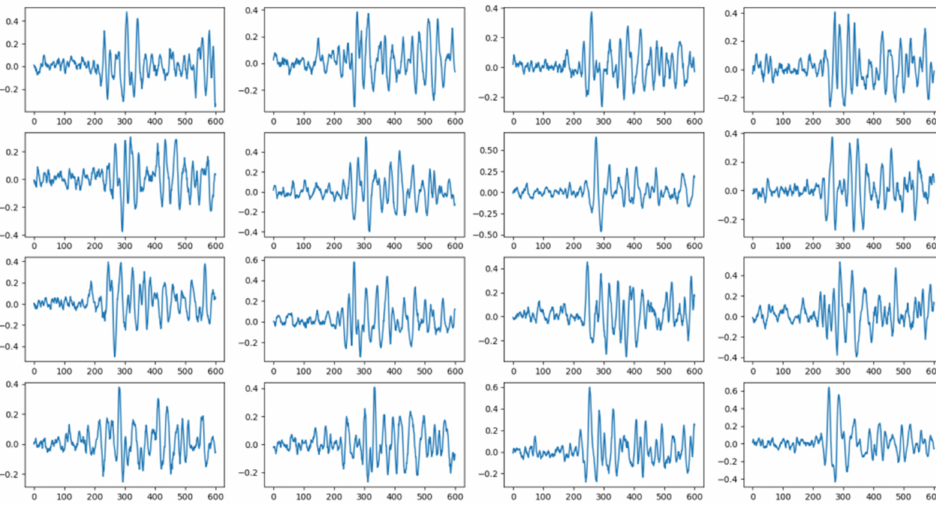
Figure 5. Seismic waveforms generated by the GAN